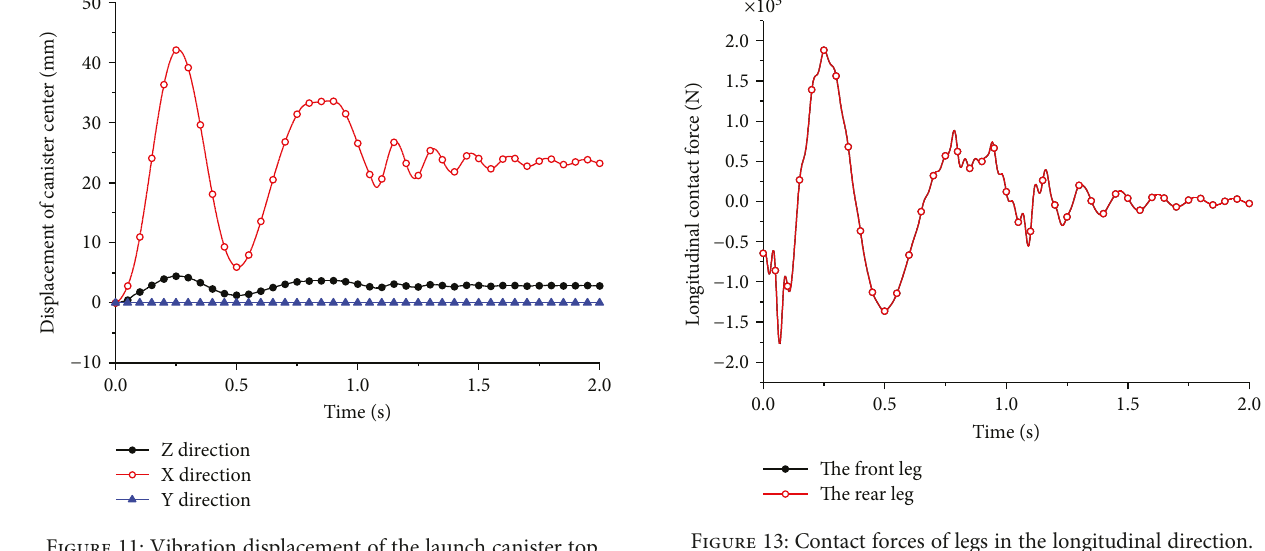
Figure 11: Vibration displacement of the launch canister top.